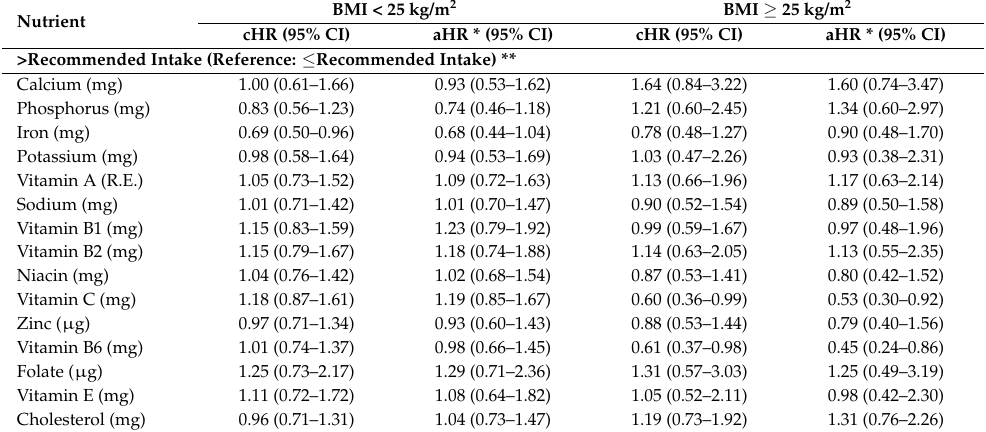
Table 4. Adjusted HR (95% CI) of breast cancer risk for recommended nutrient intake according to